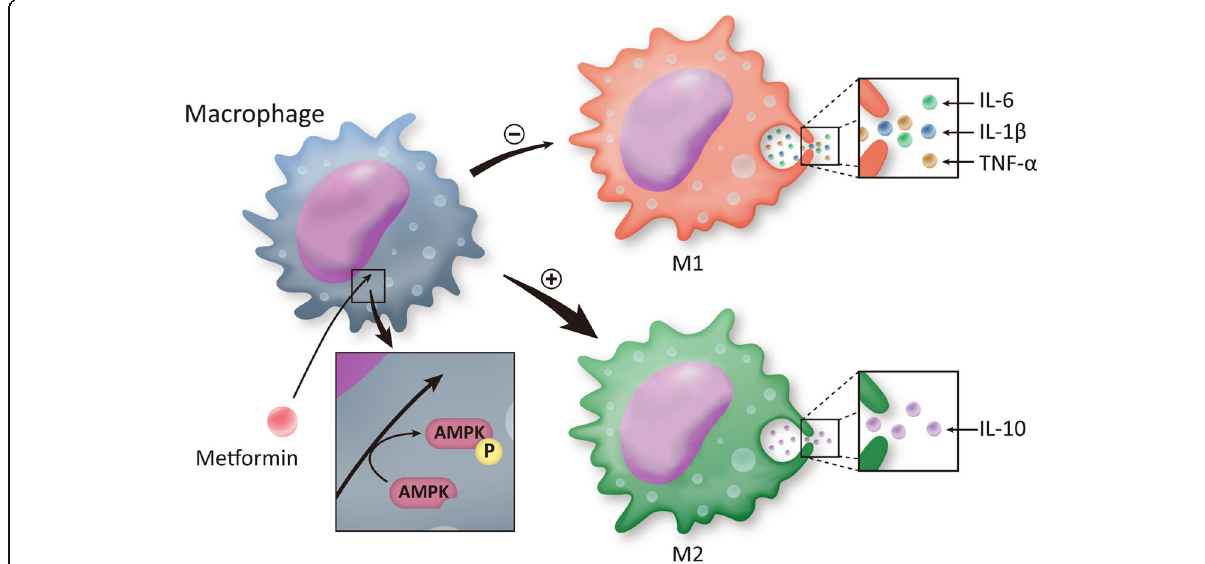
Fig. 7 Metformin promoted polarization of macrophages to an anti-inflammatory phenotype via AMPK